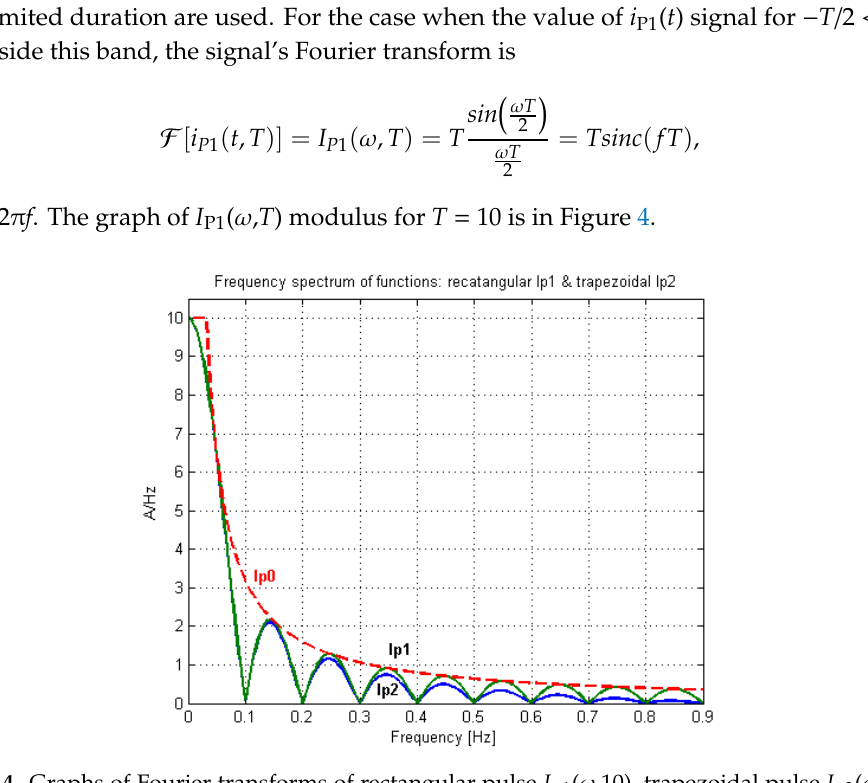
Figure 4. Graphs of Fourier transforms of rectangular pulse I p1 ( ω ,10), trapezoidal pulse I p2 ( ω ,10,1) and envelope function I p0 ( ω ,10)—dashed line.